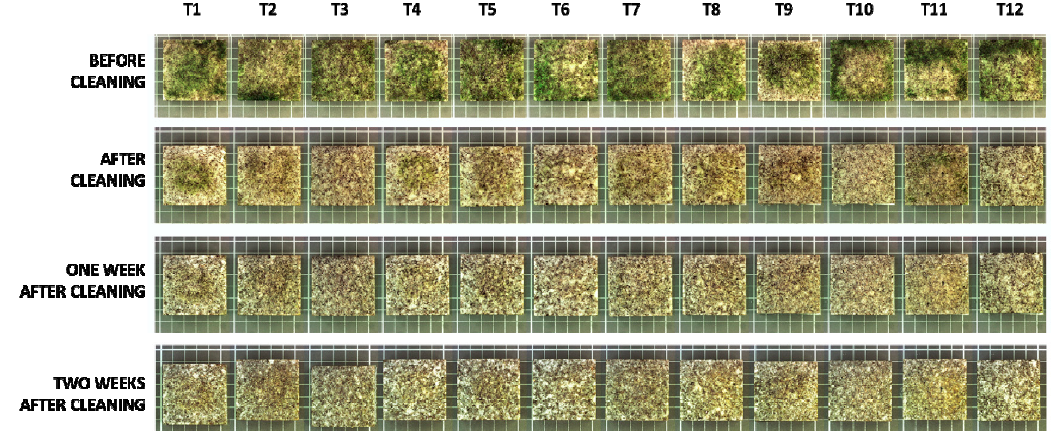
Figure 3. Macroscopic appearance of the samples studied throughout the experimental period.